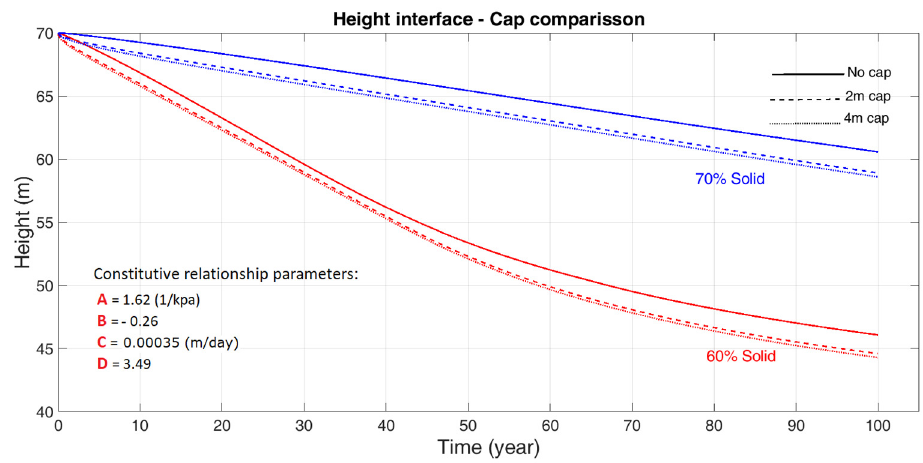
Figure 8. Settlement curves: surcharge scenarios—a thickened tailings case.